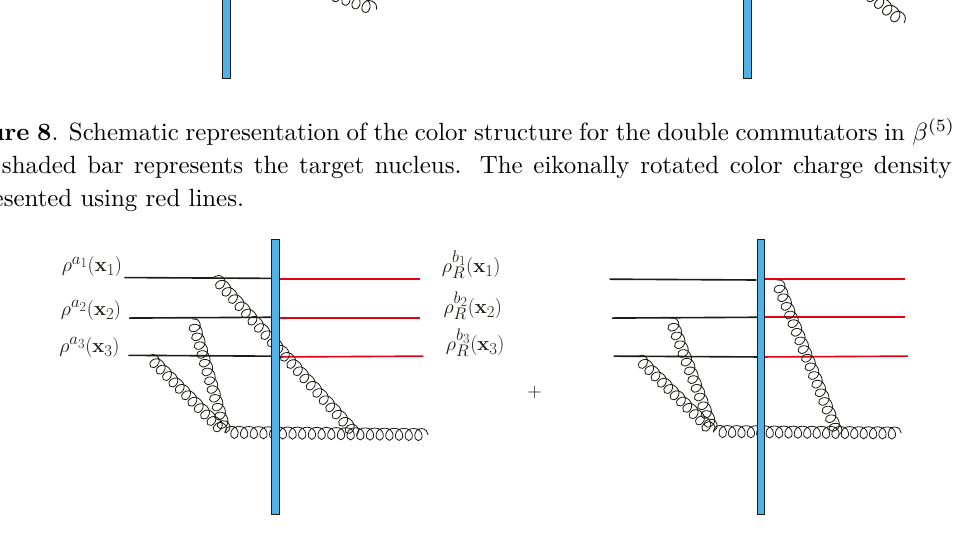
Figure 9 . Schematic representation of the color structure for the single commutators involving in β (5) ( τ, k ) . The shaded bar represents the target nucleus. The eikonally rotated color β (3) , β (3) ⊥ charge density ρ is represented using red R